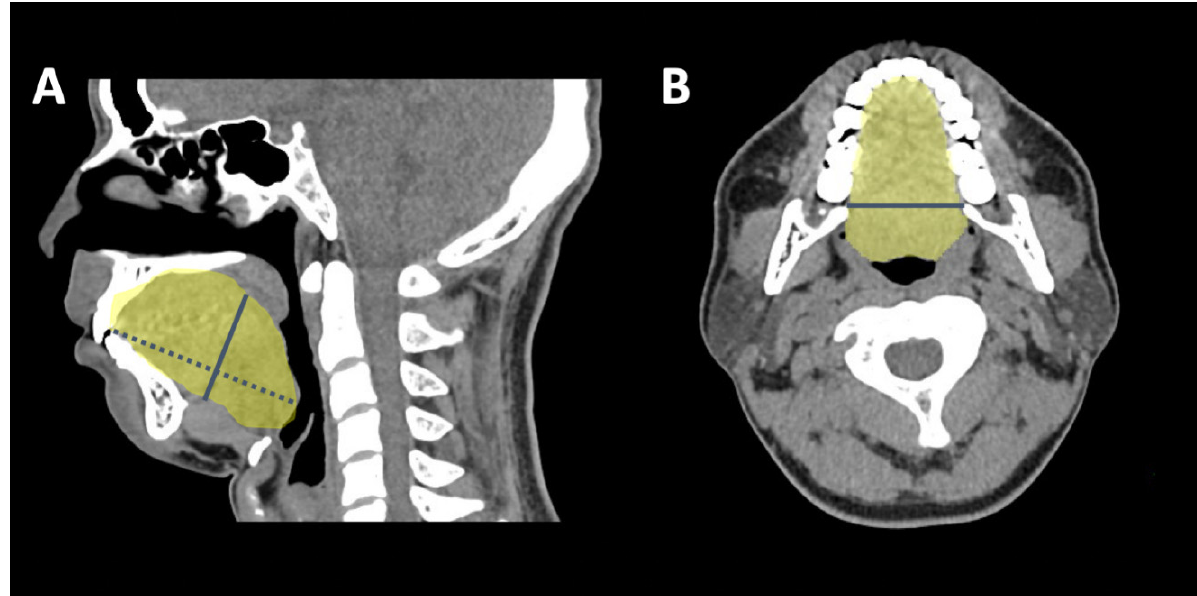
Figure 1. ( A , B ): Tongue length is the anterior–posterior length of the tongue and was measured from the upper incisor to the upper margin of the epiglottis in the sagittal view of the computed tomography scan. Tongue height was measured as a line vertical to the tongue length and crossing the midline of the soft palate ( A ). Tongue width was measured as the maximal lateral diameter of the tongue in the axial section ( B ).